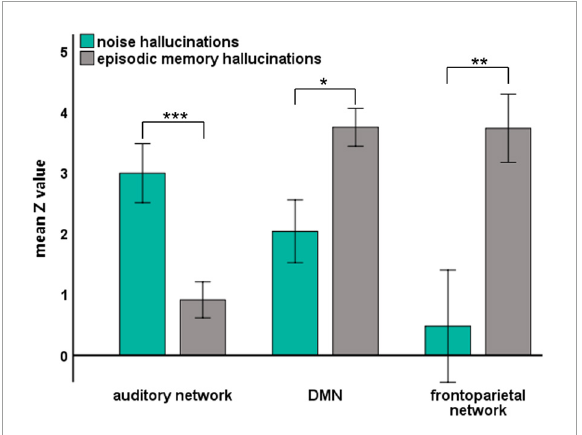
FIGURE4 The mean HGP z -values of each auditory hallucinations condition in three brain networks. Significant group differences were denoted with asterisks (error bars indicate ± 1 SEM, * p < 0.05, ** p < 0.01, and *** p <